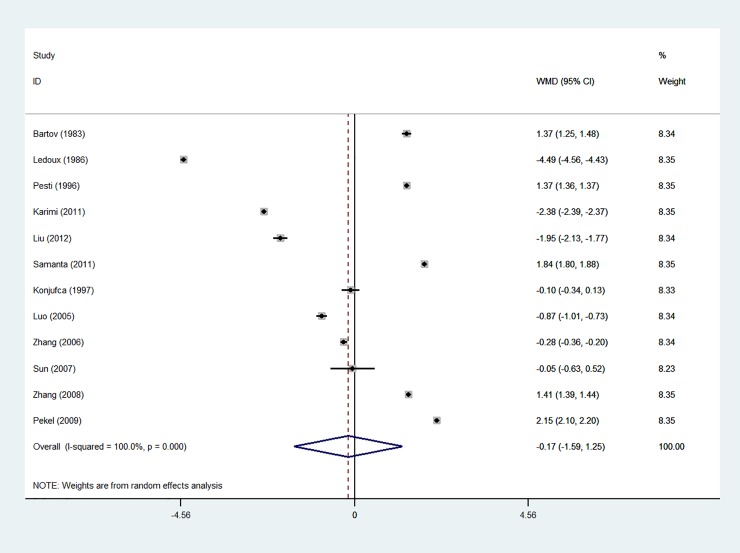
Forest plot of ADG.